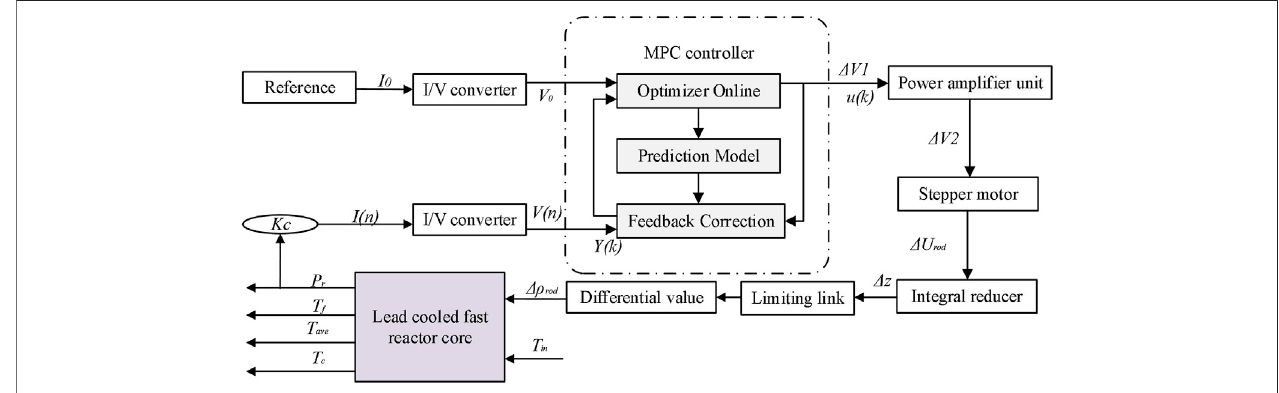
FIGURE 2 | LFR core power control system with MPC controller.